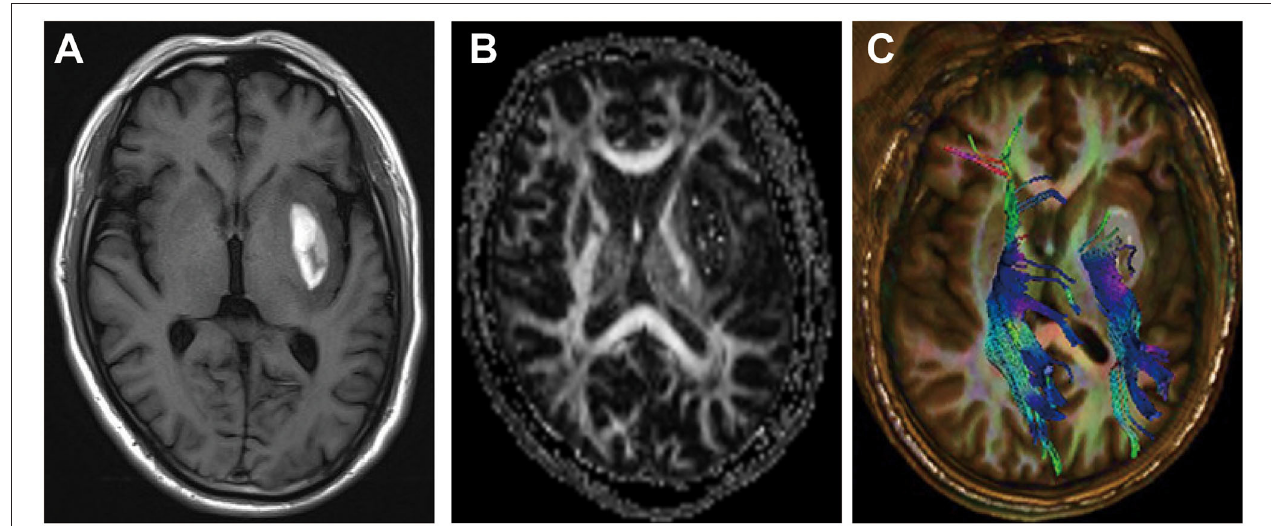
FIGURE 2 | Example of white matter injury (WMI) after intracerebral hemorrhage (ICH). (A) T1-weighted image after ICH. (B,C) Diffusion tensor images of WMI after ICH.